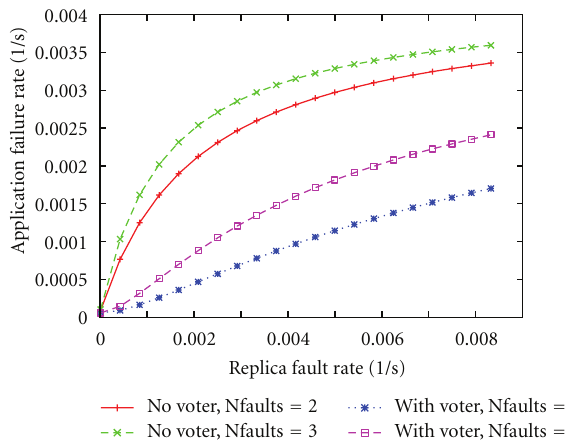
Figure 7: Application failure rate (fail/sec.) versus the replica fault rate under multiple